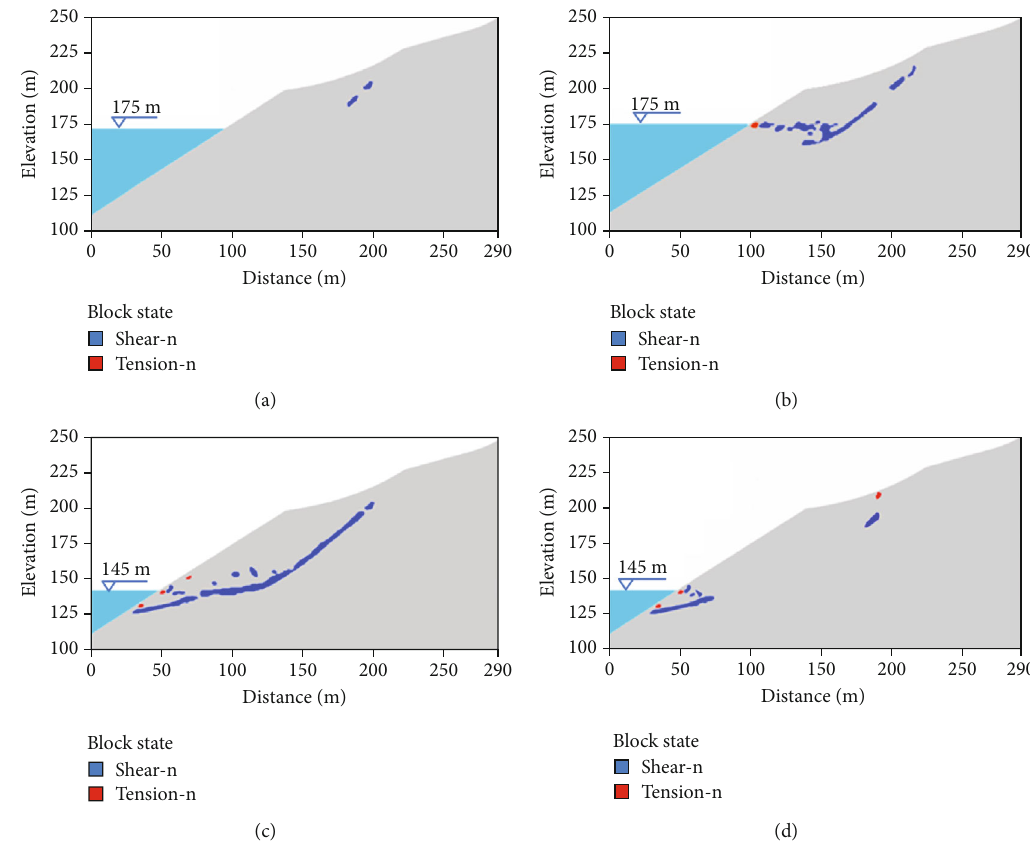
Figure 10: The change rule of plastic zone with the time: (a) 20 days; (b) 60 days; (c) 80 days; (d) 120